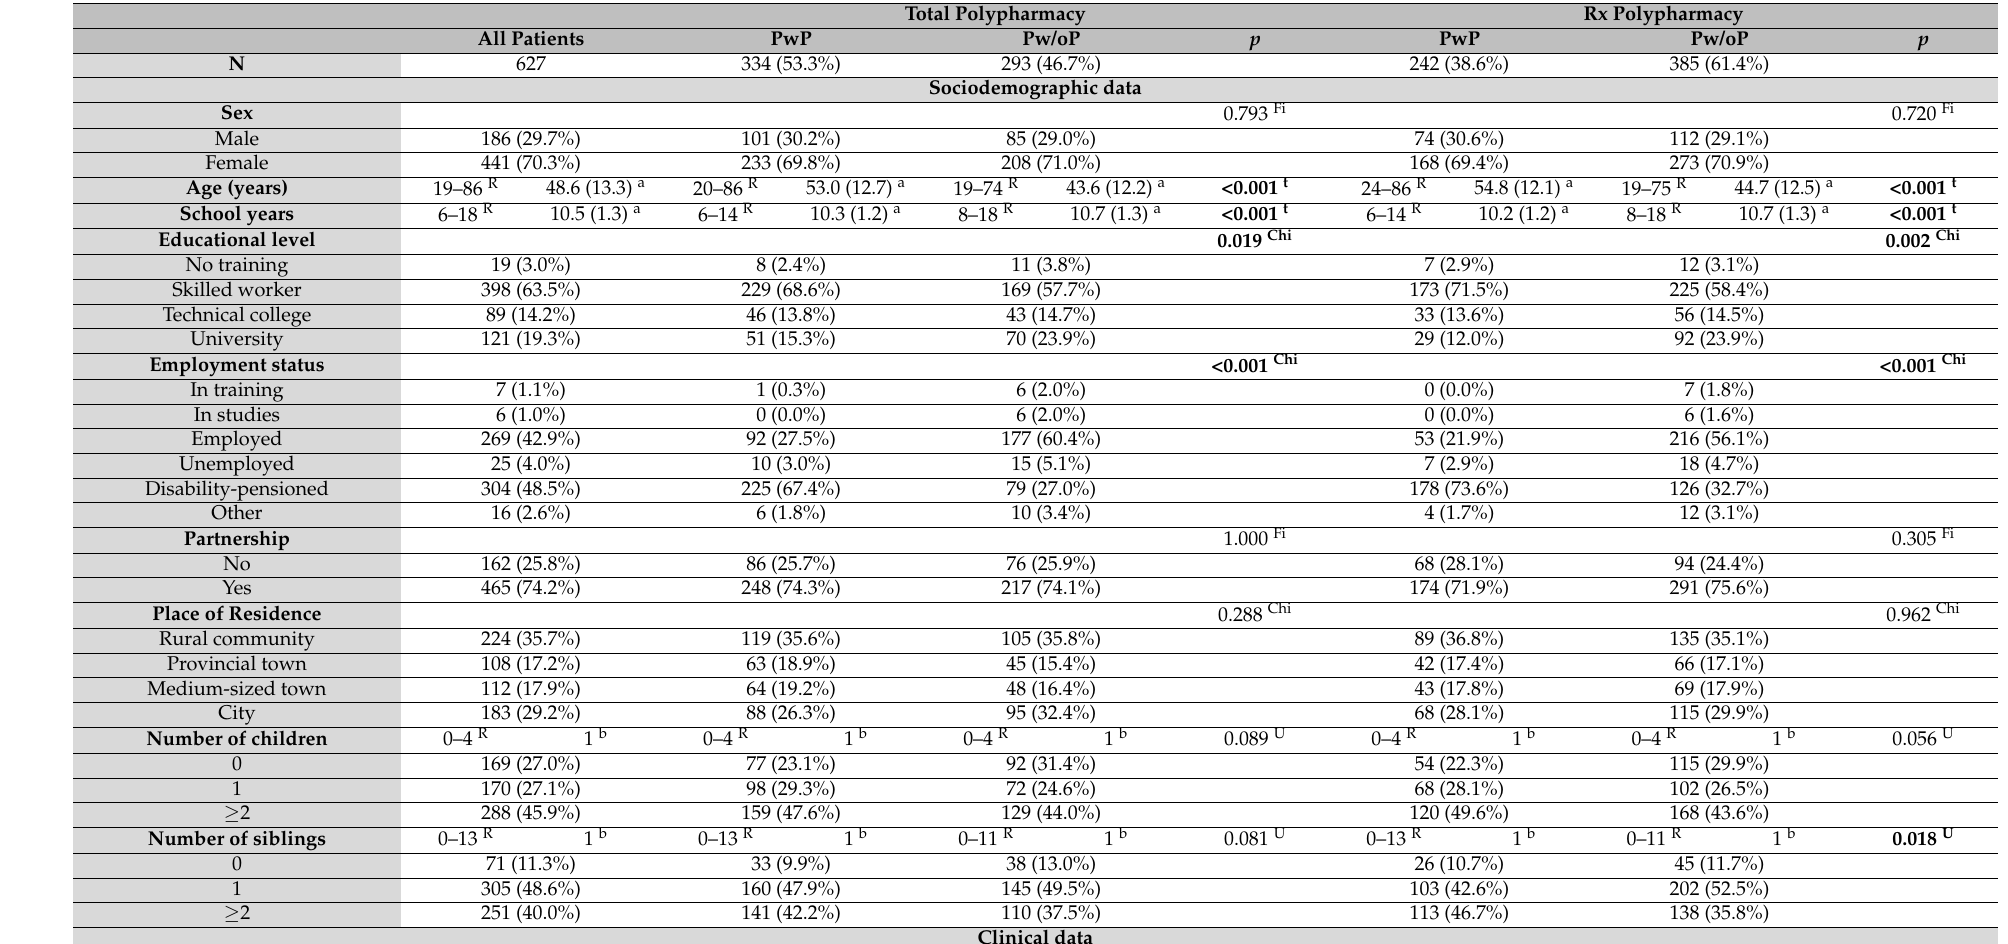
Table 1. Sociodemographic, clinical and pharmaceutical data of patients with MS, stratified by polypharmacy